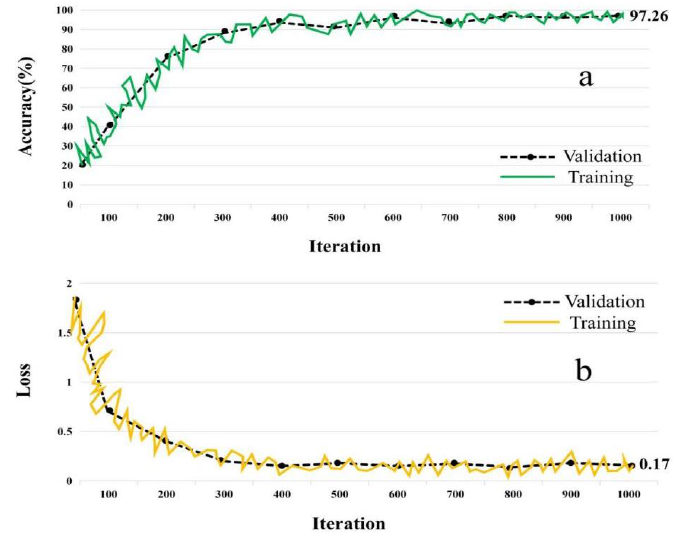
Figure 9. Deep learning graph of sand-grain pictures: ( a ) accuracy curve of FCN-ResNet50, ( b ) loss- function curve of FCN-ResNet50.